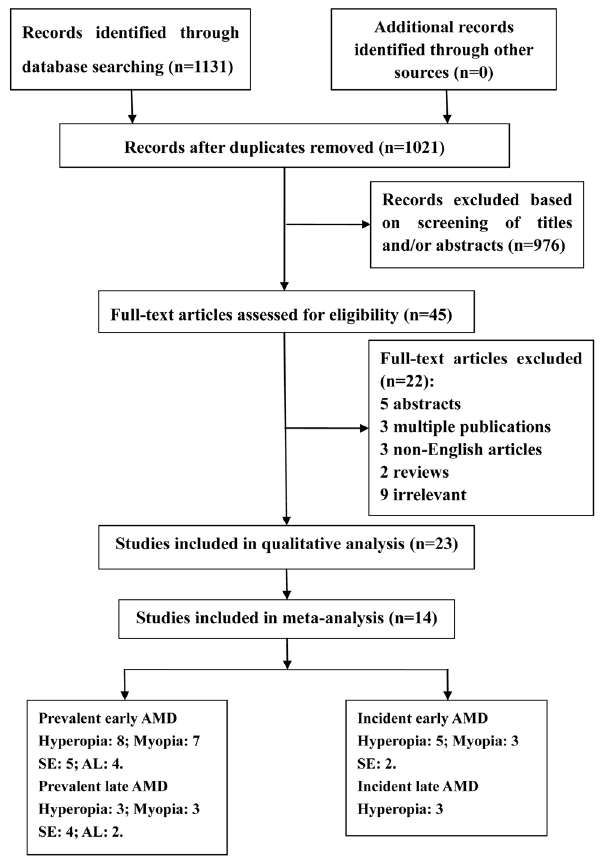
systematic review and meta-analysis. SE, spherical equivalent; AL, axial